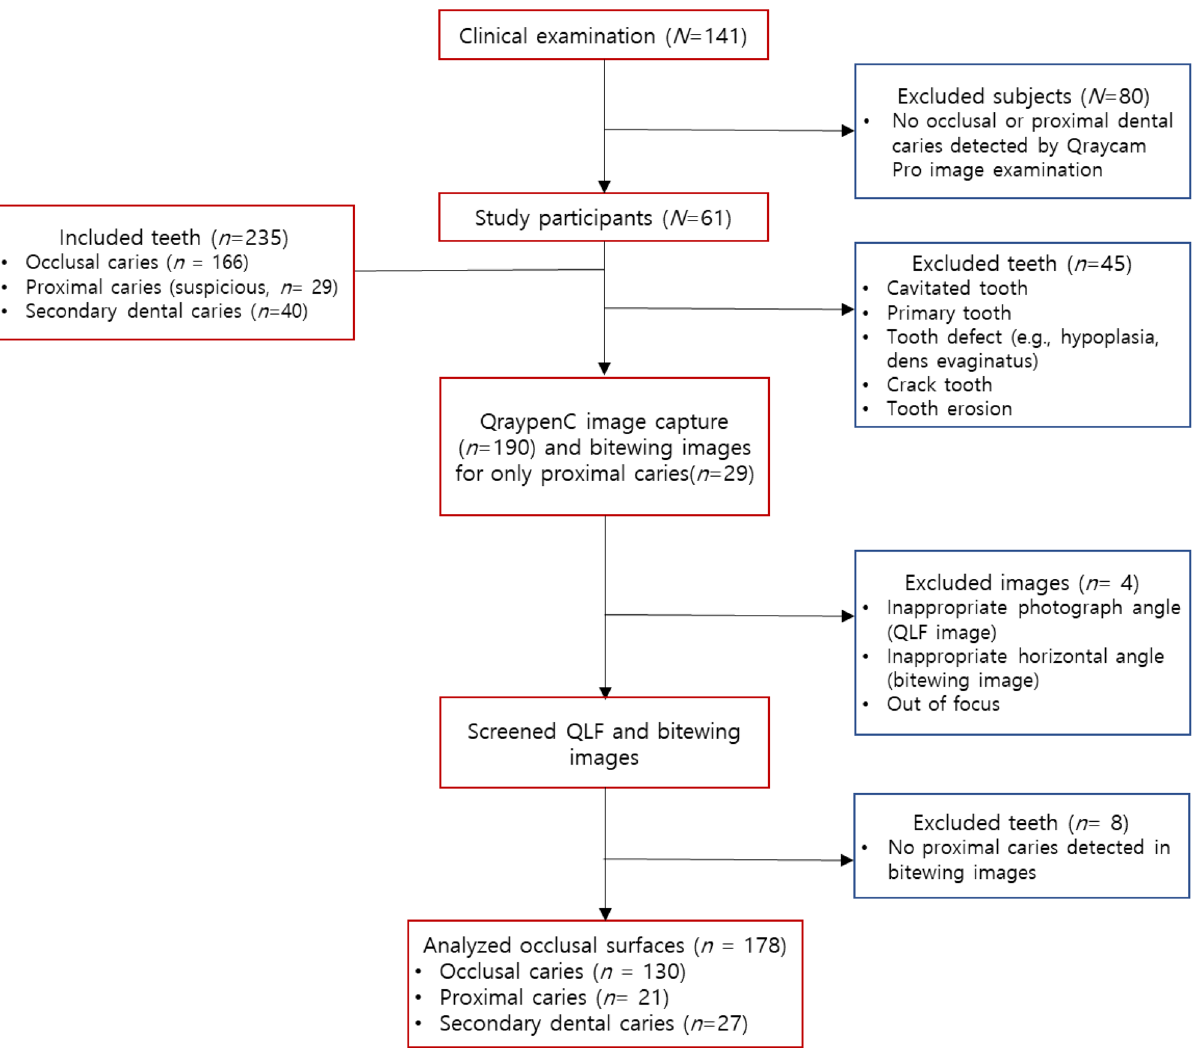
Figure 3. Flow diagram of the inclusion and exclusion for the diagnosis of dental caries (N = number of subjects, n = number of